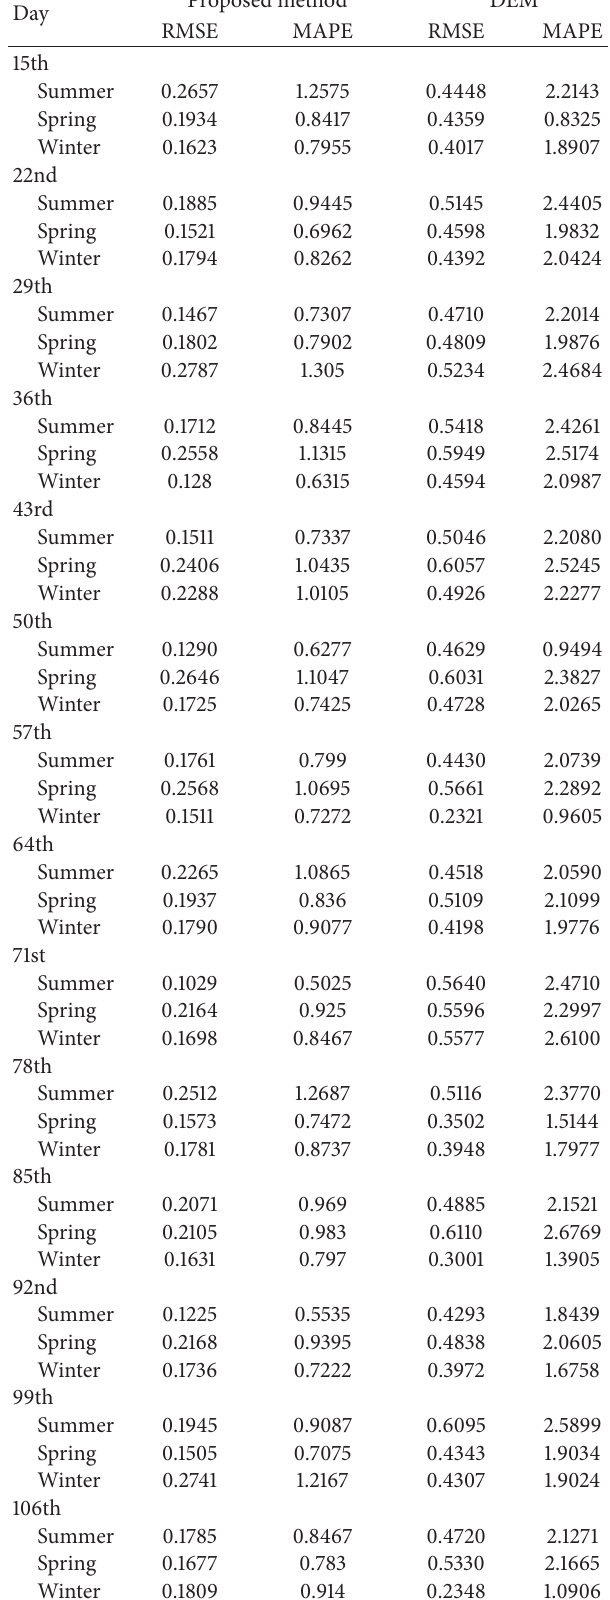
Table 2: The parameters of the adaptively fitted double exponential smoothing models.